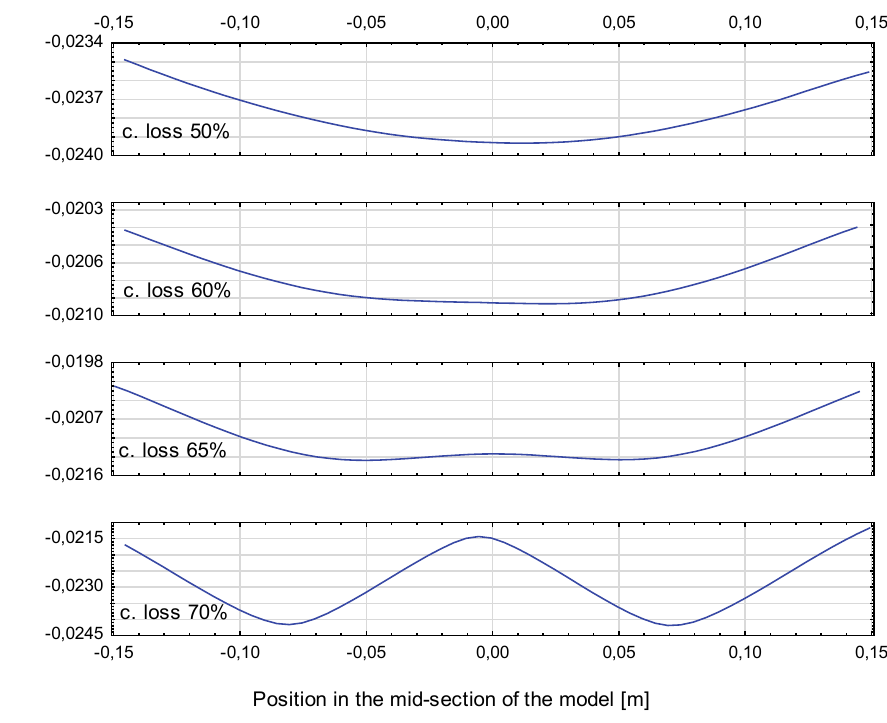
Fig. 6. FEM simulation results. Vertical displacements in the upper mid-section of the guide model for maximum bending moments